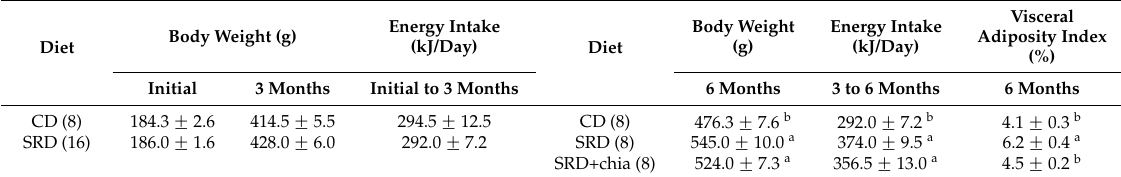
Table 3. Body weight, energy intake and adiposity index of rats fed a control diet (CD), sucrose-rich diet (SRD) or SRD + chia seed (SRD + chia) 1